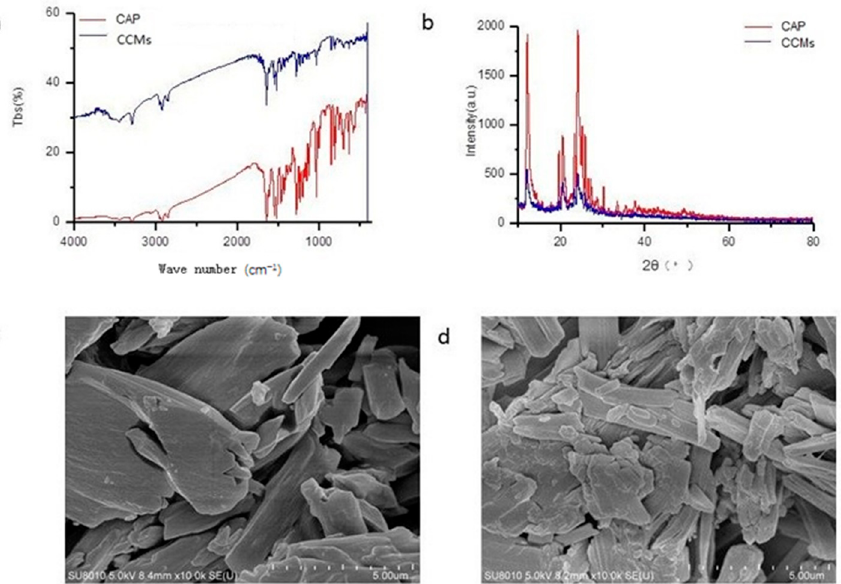
Figure 2. Biophysical characterization of the synthesized CCMs. ( a ) Fourier infrared spectra at different wavelengths; ( b ) the XRD patterns; ( c , d ) SEM image of the CAP and CCMs. CAP, capsaicin; CCMs, capsaicin/chitosan microcapsules.